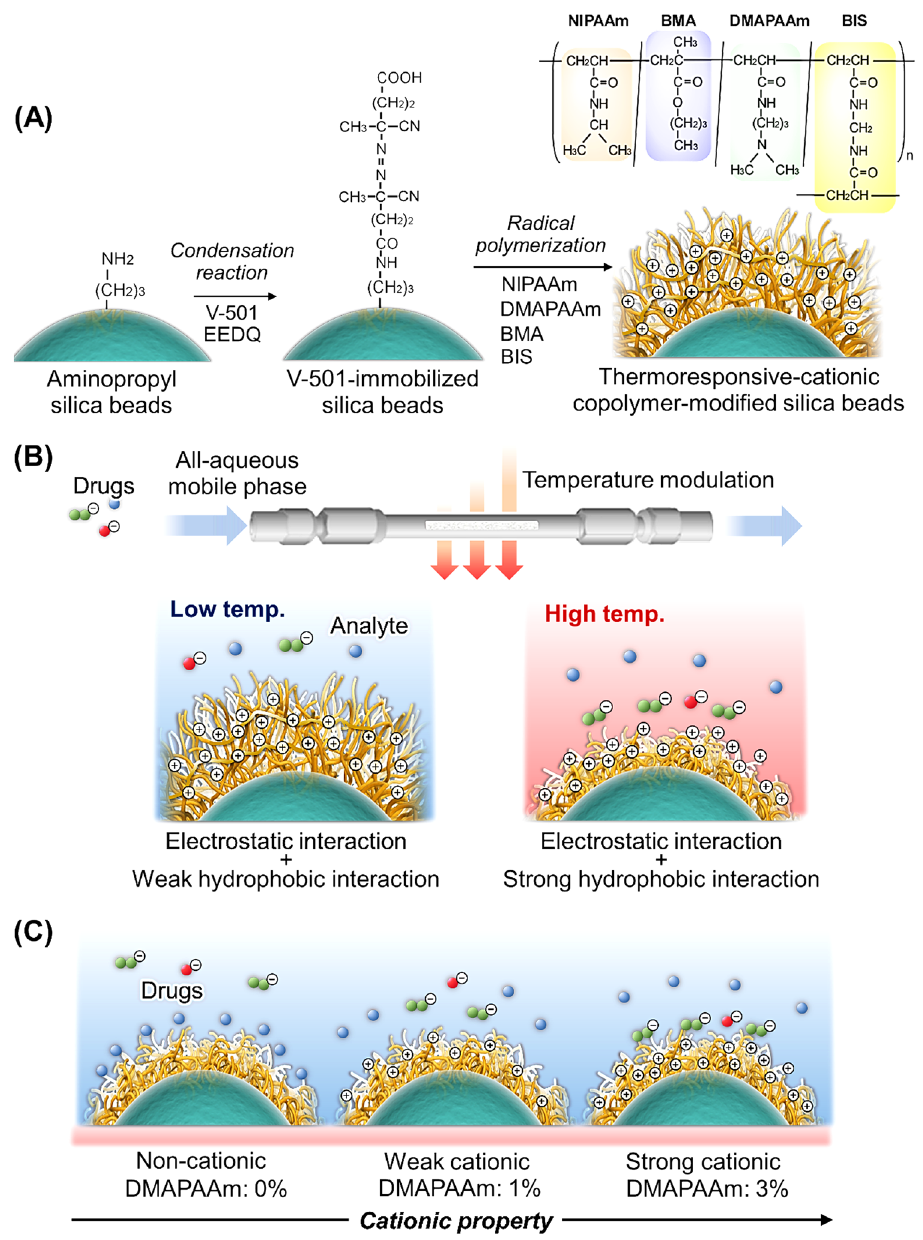
Figure 1. Thermoresponsive anion-exchange chromatography for therapeutic drug monitoring. ( A ) Schematic diagram of the preparation of a thermoresponsive cationic hydrogel. ( B ) Temperature-responsive property change of the modified copolymer on silica beads. ( C ) Electrostatic and hydrophobic interactions between the thermoresponsive cationic hydrogel and drugs in a chromatography